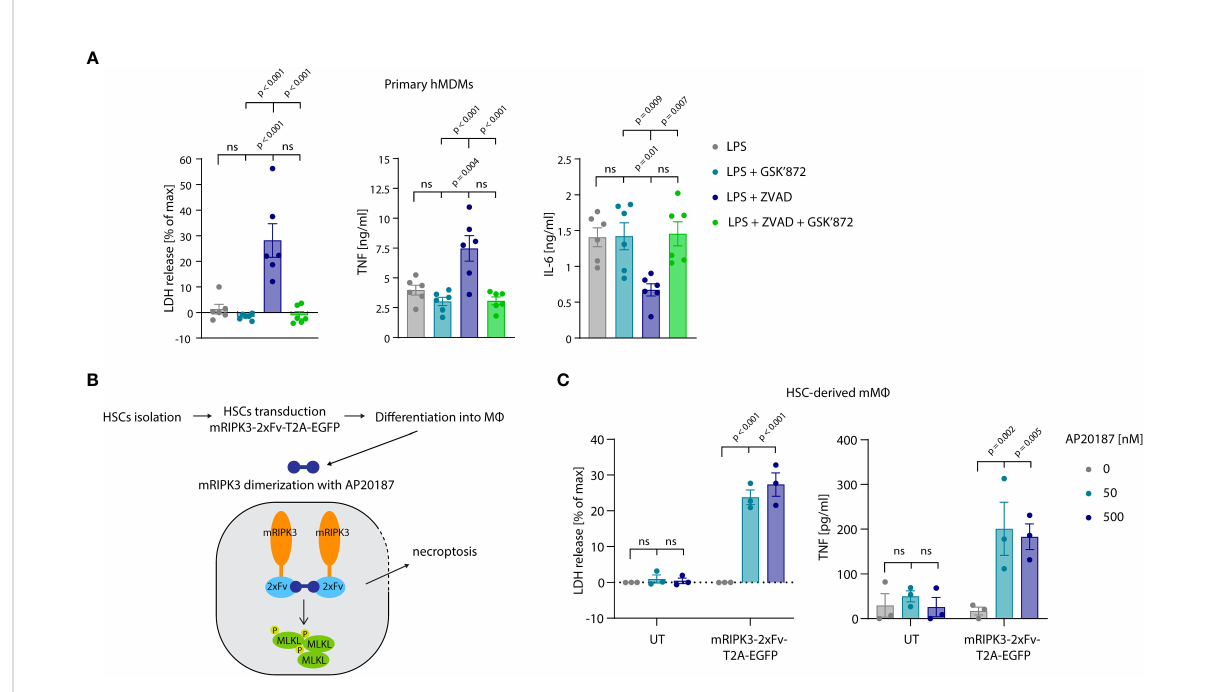
FIGURE 7 Necroptosis driven TNF release in primary cells. (A) Primary hMDMs were stimulated for 8 h with 0.2 ng/ml LPS and the speci fi ed inhibitors (GSK ’ 872 = 3µM, ZVAD = 20 µM). LDH release and cytokine production were measured. (B) Schematic overview of experimental set-up with HSC-derived macrophages. (C) HSC-derived macrophages left untransduced (UT) or transduced with pFUGW-mRIPK3-2xFv-T2A-EGFP were stimulated with the indicated amount of AP20187 for 15 h LDH and TNF release were measured. Data are depicted as mean ± SEM of six different donors (A) or of three independent experiments (C) . Statistics indicate signi fi cance by one-way ANOVA (A) or two-way ANOVA (C) with a Tukey (A) or Dunnett (C) correction for multiple testing. P values as indicated or ns, not signi fi